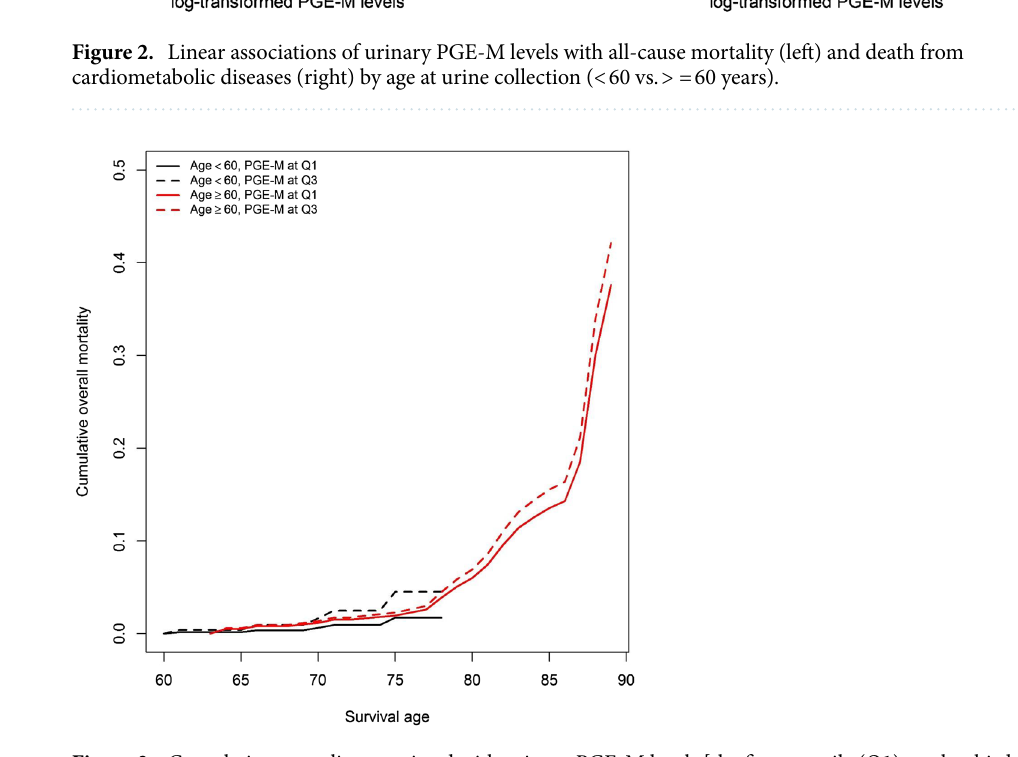
Figure 3. Cumulative mortality associated with urinary PGE-M levels [the first quartile (Q1) vs. the third quartile (Q3)] by age at urine collection (< 60 vs. > = 60